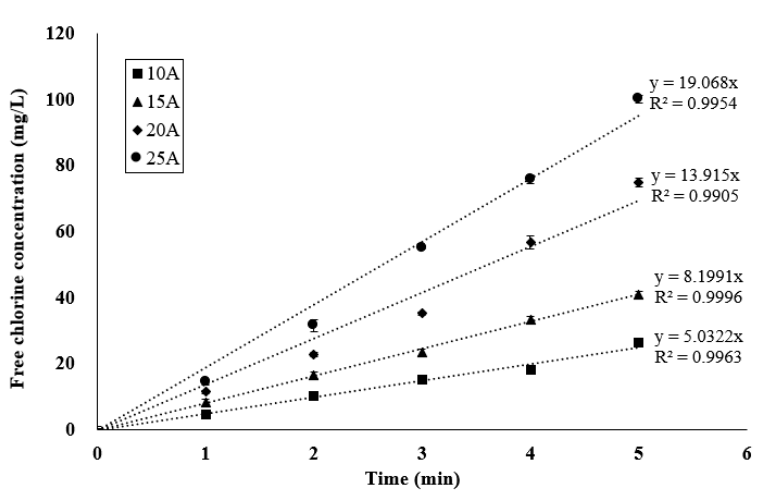
Figure 5. Free chlorine concentrations in West Sea water under different current conditions in an in-situ electro-chlorination system.